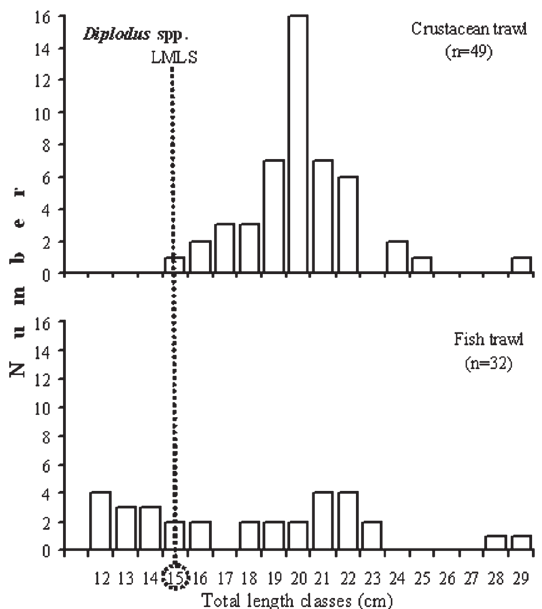
Fig . 10. – length frequency distribution of the fish trawl target spe- cies Diplodus spp. (seabream) (lMls=legal Minimum landing size).